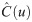
(A) Experimentally obtained cross-correlograms of MC neurons in macaque monkey during a tracking task (blue) and Gaussian fit (red). Top, Middle: for neuron pairs recorded by the same electrode, respectively (using spike-sorting). Top shows the thinnest correlation peak (σ = 9.8 ms) and Middle shows the widest (σ = 89.3 ms). Bottom: For two neurons recorded by distinct electrodes. (B) Illustration of Gaussian-shaped external cross-correlations C^(u) with width σ^=Φ(σ) (thin black line) and resulting network cross-correlation C(u) with width σ (thick blue line). (C) Relative differences (J¯†-J¯)/Jmax for all group-averaged synapses, as a function of stimulation delay d†, for the model network fitted to two extremal values of correlation width. Top: σ = 10 ms. Bottom: σ = 90 ms. (D) Relative differences for averaged synaptic strengths from group a to group b ((J¯ba†-J¯ba)/Jmax) as a function of stimulation delay d† and fitted correlation peak width σ. Black dotted line corresponds to best fit plotted in E. (E) Superposition of relative difference for J¯ba and normalized mean torque change from spike-triggered conditioning experiments on macaque monkeys. Experimental data from Figure 4 of [10]; error bars show the standard error of the mean. Best fit between model and experimental curve is for σ ≃ 17 ms (see black dotted line in D).